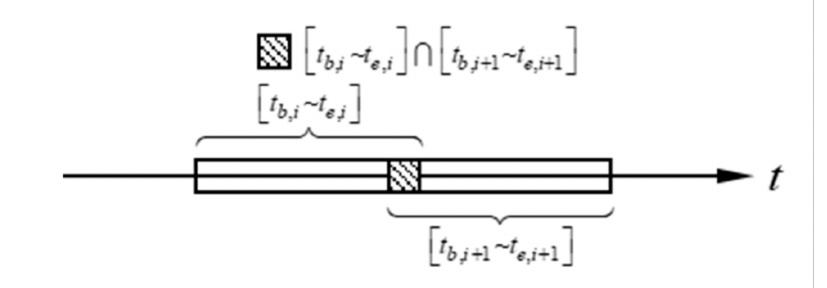
Figure 1. Division of time